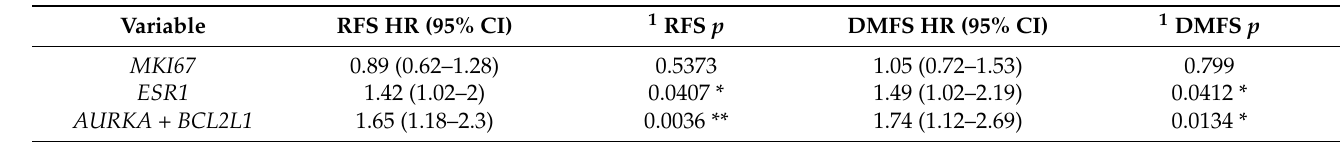
Table 1. Multivariate analysis of RFS and DMFS according to MKI67 , ESR1 , AURKA and BCL2L1 expression in TNBC